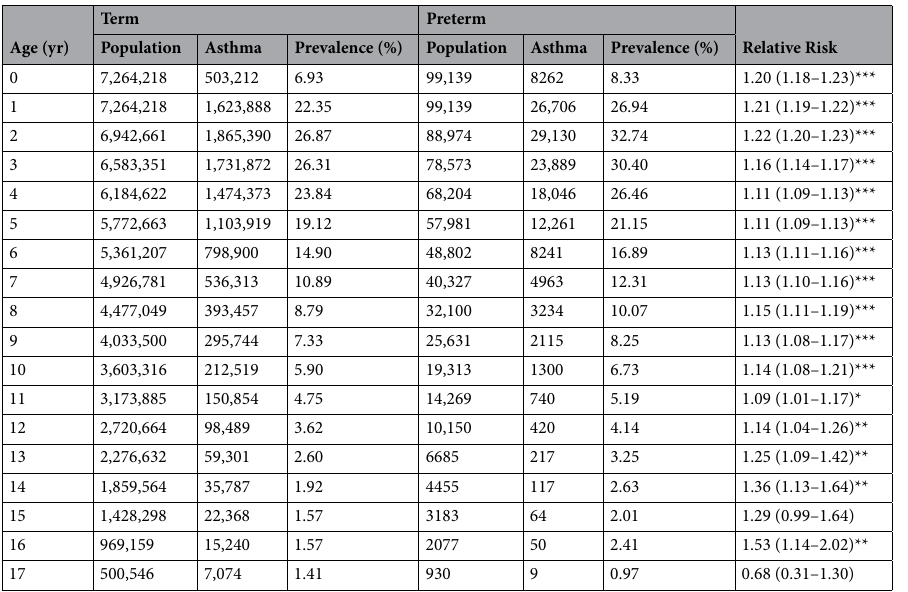
Table 1. Asthma prevalence stratified by age. * p < .05; ** p < .01; *** p <